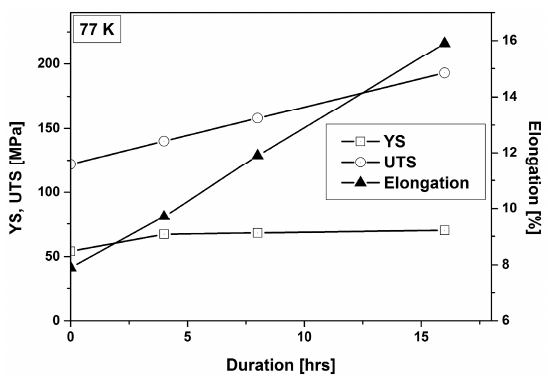
Figure 1. Yield strength (YS), ultimate tensile strength (UTS), and elongation to fracture of AE42 against deep cryogenic treatment (DCT) duration (redrawn after Figure 5 in [10]).